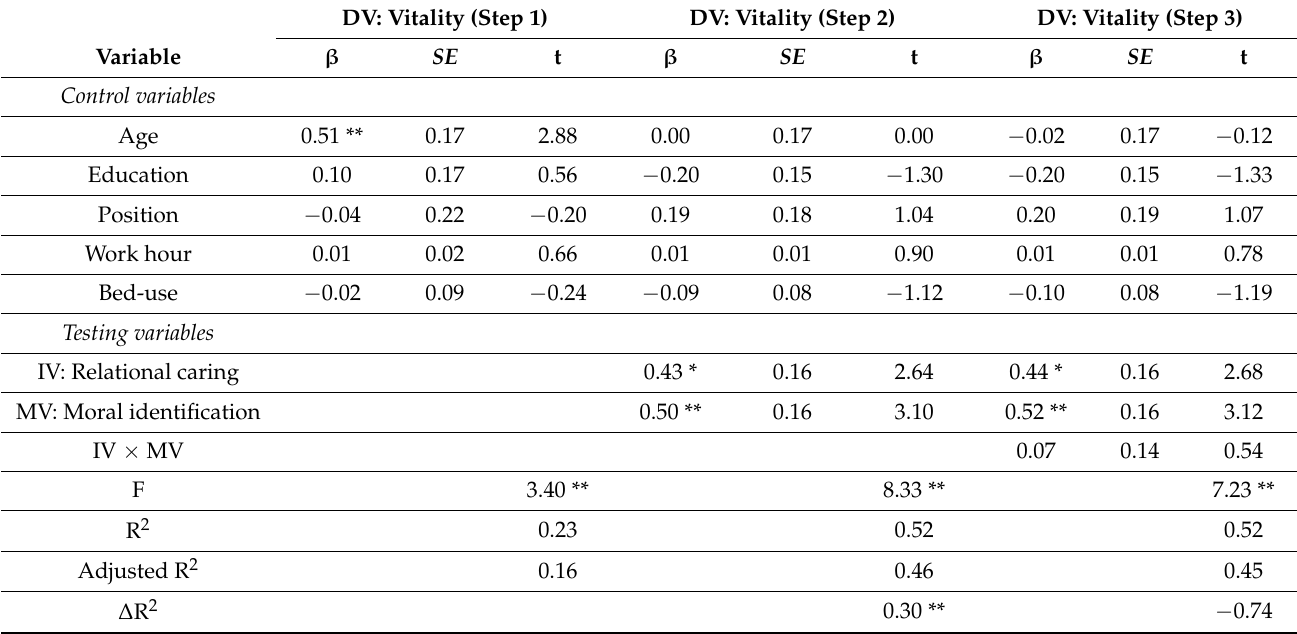
Table 5. The moderation effect of moral identification under the condition of 40+ work